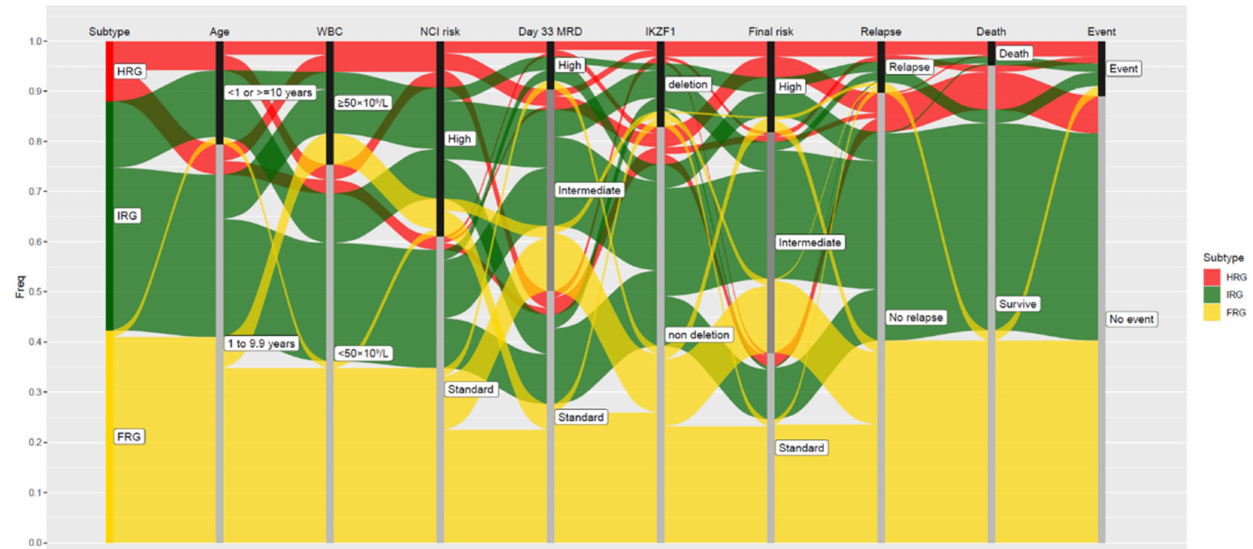
Figure 1. Interactions of genetic risk groups with various clinical prognostic risk factors and outcomes in childhood acute lymphoblastic leukemia (ALL). Each vertical stack in this Sankey diagram represents a prognostic factor or treatment outcome, with subcategories in different shades of black and gray. The relationships between various prognostic factors are demonstrated by flow lines, and the widths of the flow lines are proportional to the degree of interaction between genetics and clinical factors/outcomes. Favorable-risk subtypes are in shades of yellow, intermediate-risk subtypes are in shades of green, and high-risk subtypes are in shades of red. Day 33 MRD is categorized into three groups: standard, ≤ 0.01%; intermediate, 0.01% to 1%; high, ≥ 1%. Data are adapted from results of RNA-sequencing of children and adolescents with ALL in the Malaysia-Singapore cohort. Abbreviations: WBC, white blood cell; NCI: National Cancer Institute; MRD: minimal residual disease; HRG, high-risk genetics; IRG: intermediate-risk genetics; FRG: favorable-risk